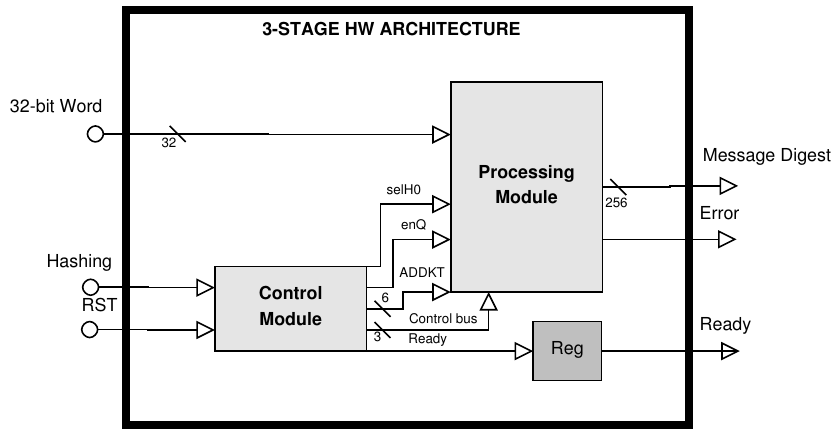
Figure 2. 3-Stage hardware architecture block diagram with error